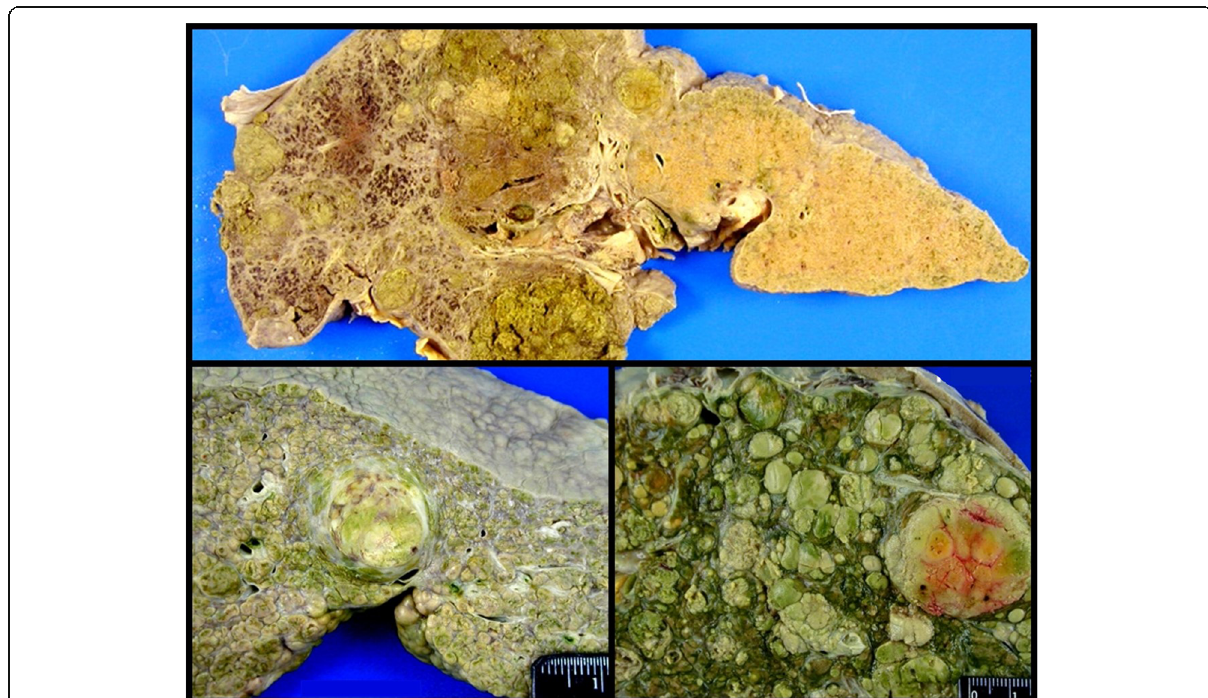
Fig. 1 HCC gross subtypes: massive form (top), nodular form (bottom-left) and diffuse form (bottom-right)